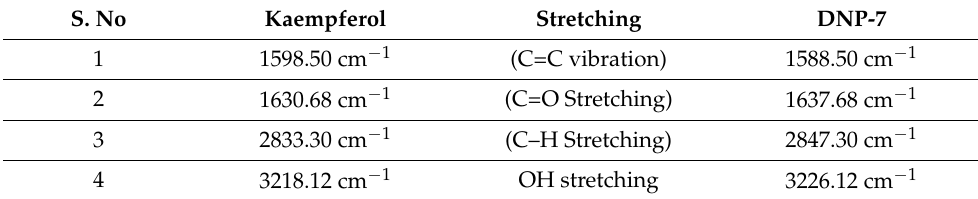
Figure 2. FTIR spectra of the Kaempferol (pure drug) and the prepared Kaempferol nanoparticle.